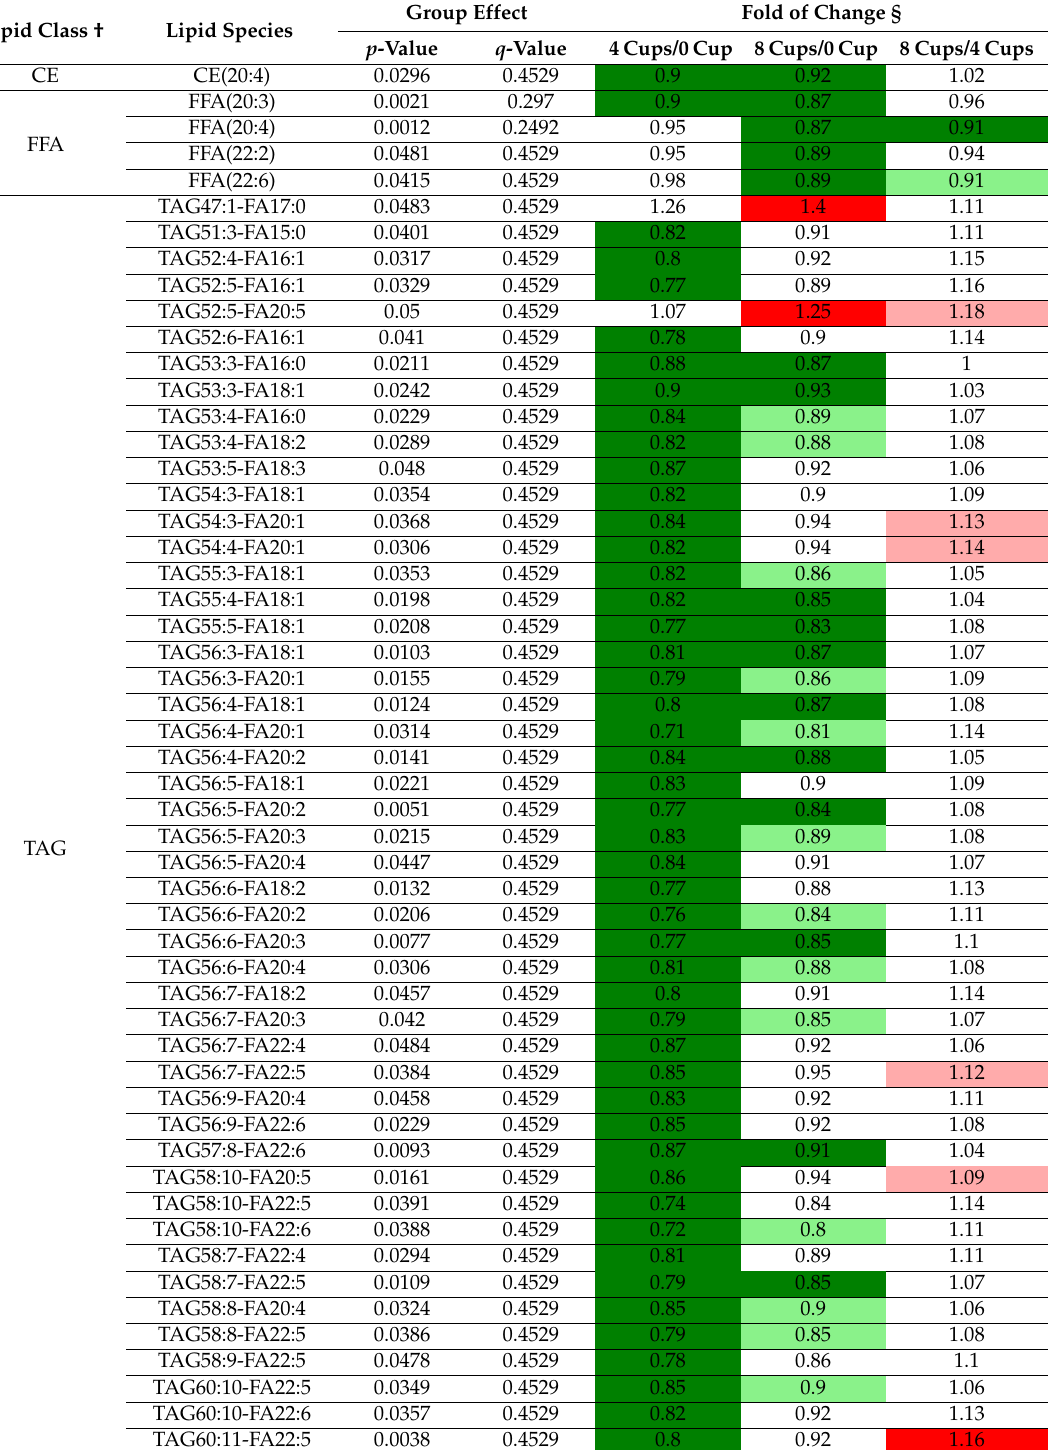
Table 1. Significant lipid markers of coffee consumption